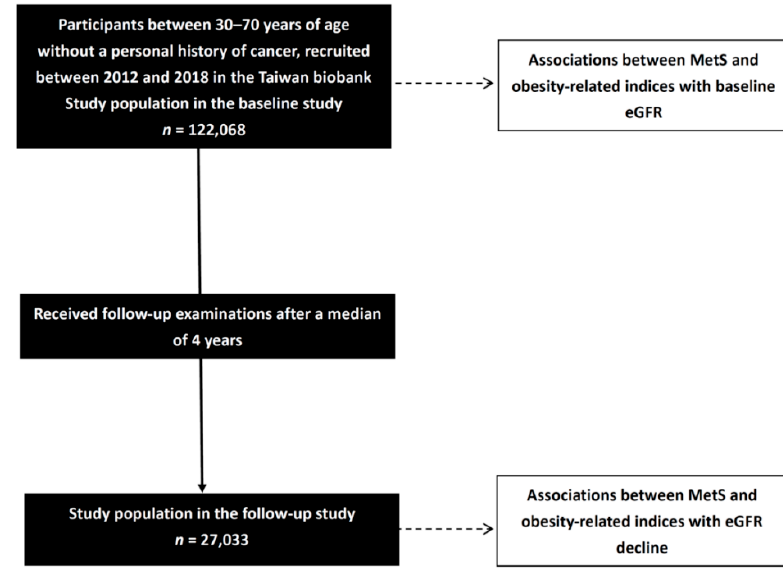
Figure 1. Flowchart of the study population.